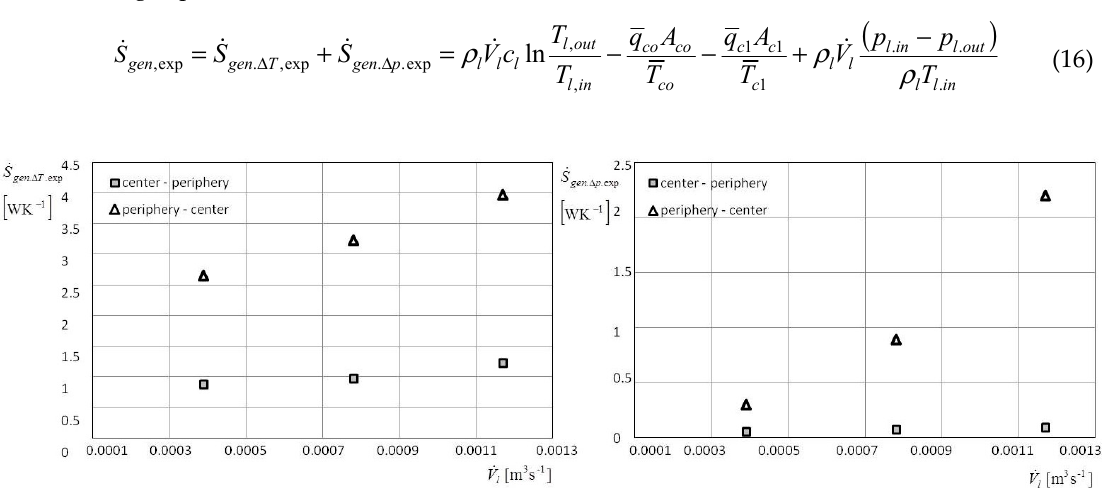
Figure 19. Experimental values of thermal and hydraulic entropy for direct and counter impinging liquid jet.